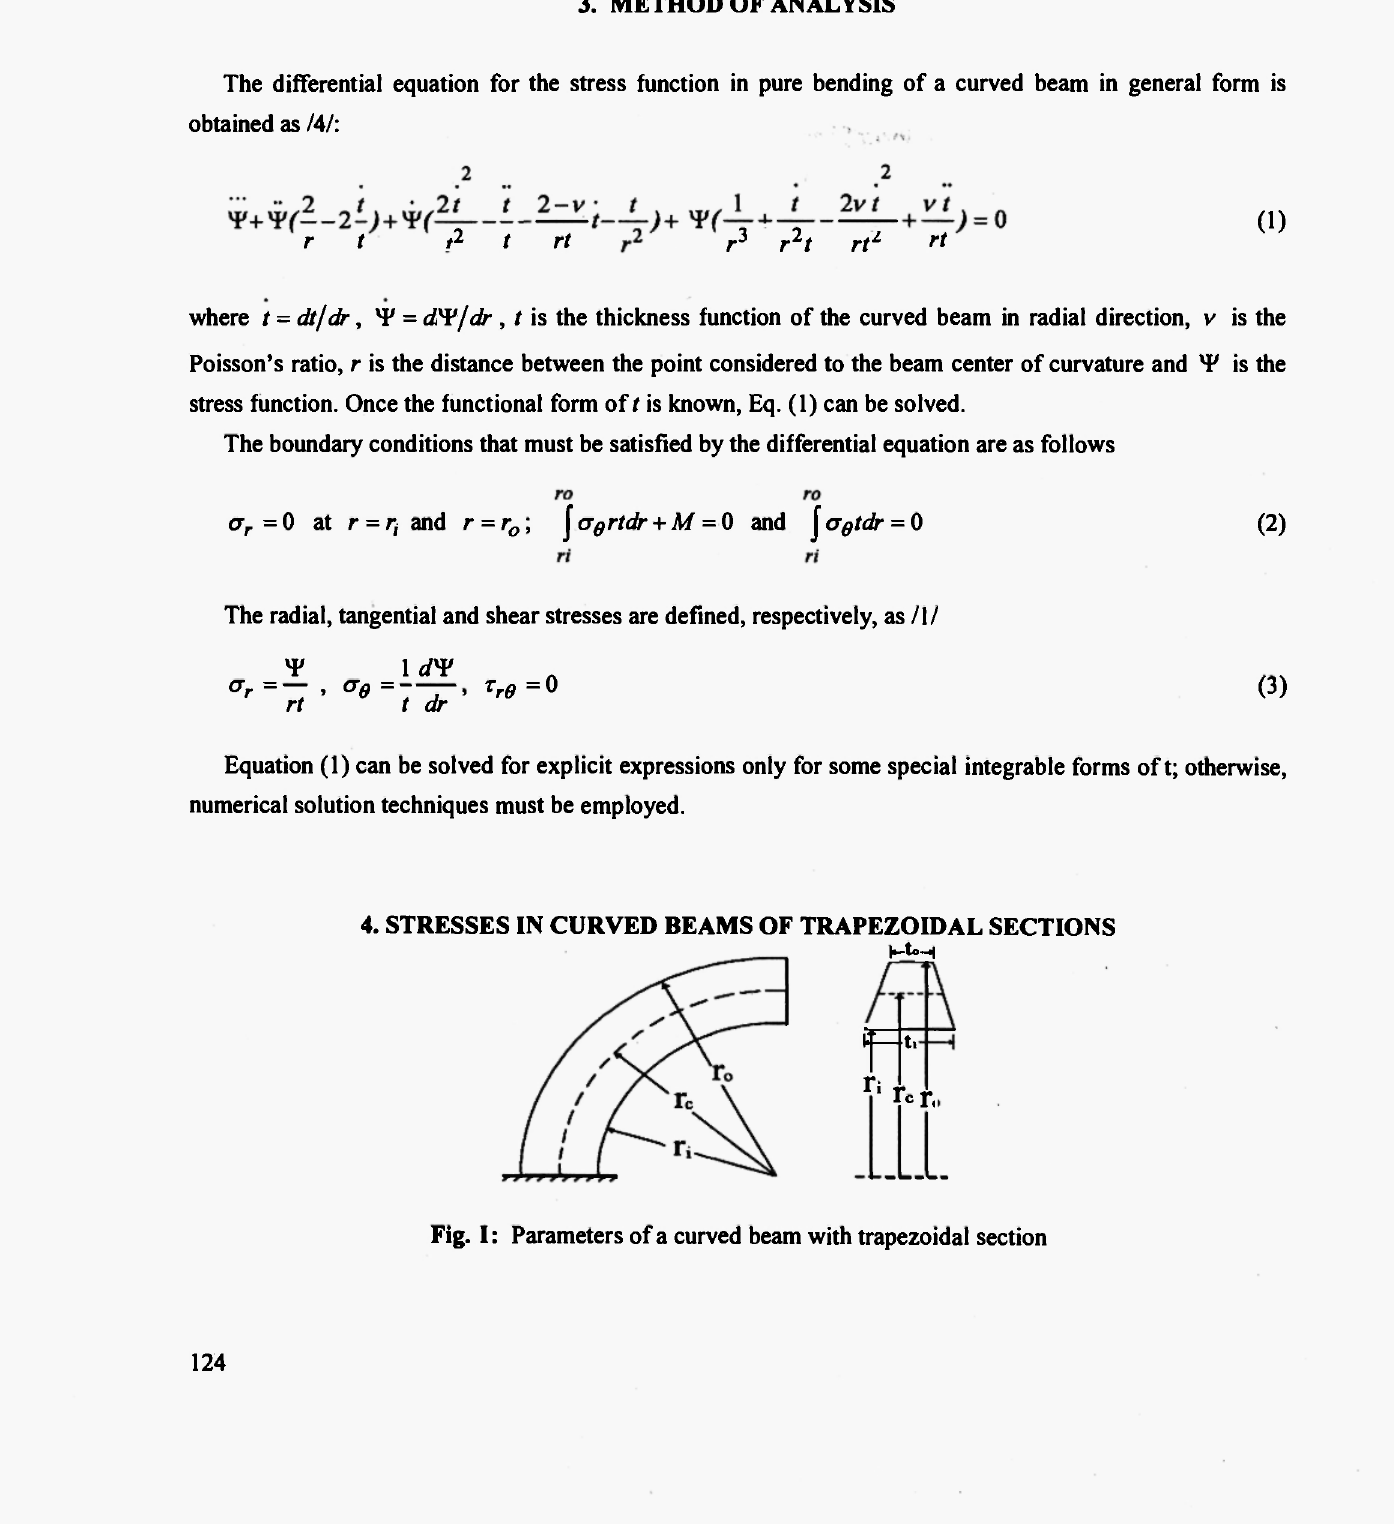
Fig. I: Parameters of a curved beam with trapezoidal